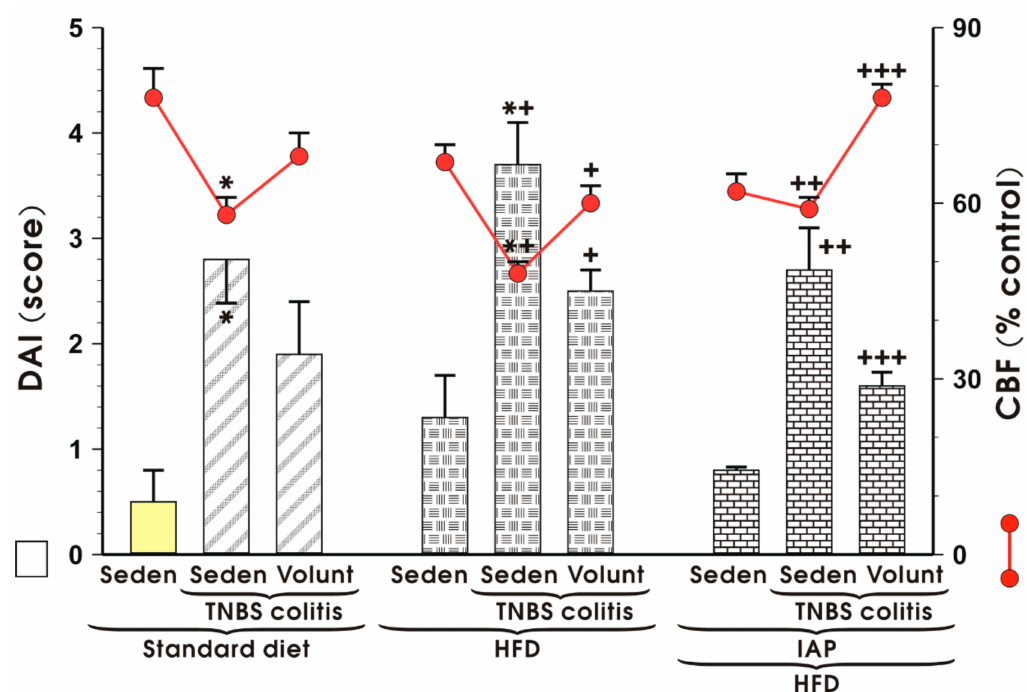
Figure 1. Effect of voluntary exercise with or without treatment with intestinal alkaline phosphatase (IAP) on the disease activity index (DAI) and the accompanying alterations in colonic blood flow (CBF), presented as red lines in this figure, in sedentary (Seden) mice with 2,4,6-trinitrobenzenesulfonic acid (TNBS)-induced colitis fed standard diet (SD) or high-fat diet (HFD). Results are mean ± S.E.M. of eight animals per group, * significantly different ( p < 0.05) from sedentary mice fed SD, * + significantly different ( p < 0.05) from sedentary mice fed HFD, + significantly different ( p < 0.05) from animals fed SD not subjected to voluntary exercise, ++ significantly different from sedentary mice fed HFD with colitis ( p < 0.05) without IAP administration, +++ significantly different ( p < 0.05) from sedentary mice fed HFD with or without IAP